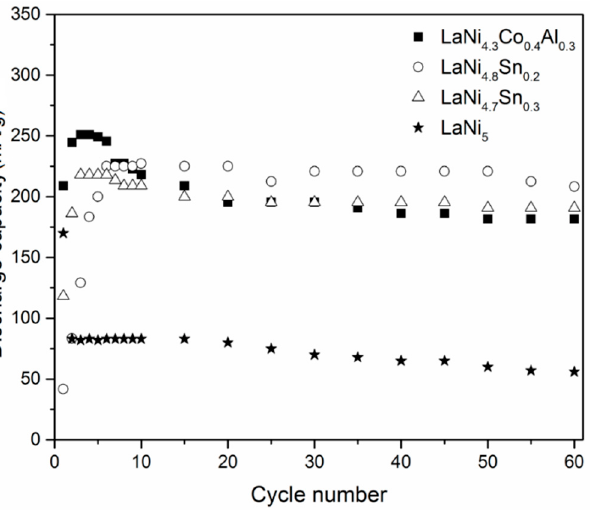
Figure 7. Discharge vs. cycle number curves for the alloys studied at a current density of 100 mA/g during charge and discharge.